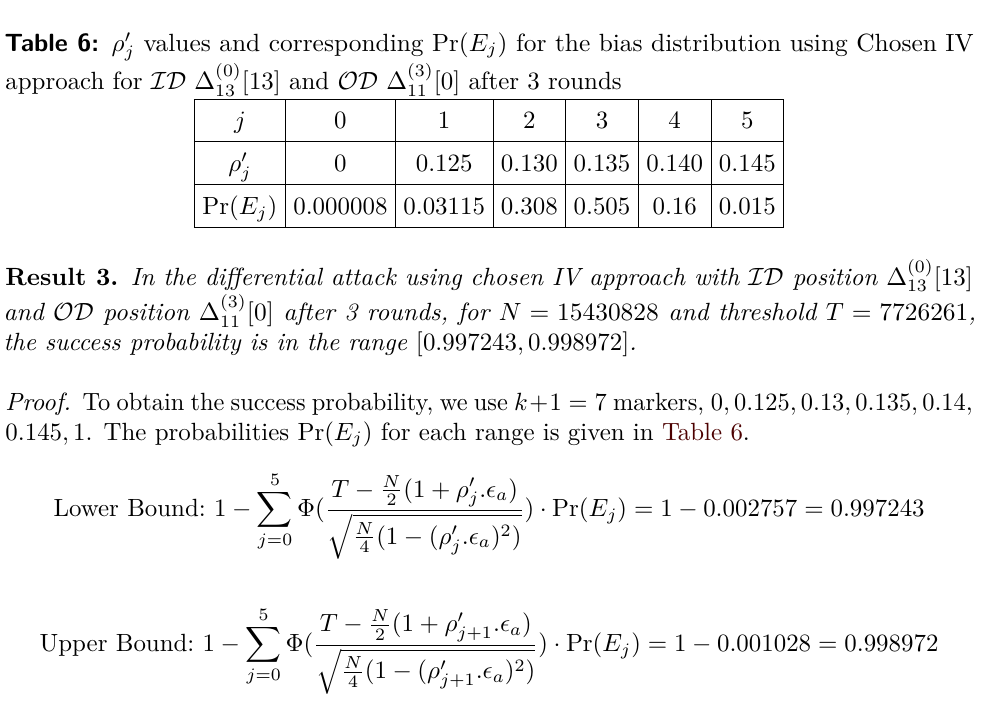
[13] and OD ∆ (3) [0] 13 11